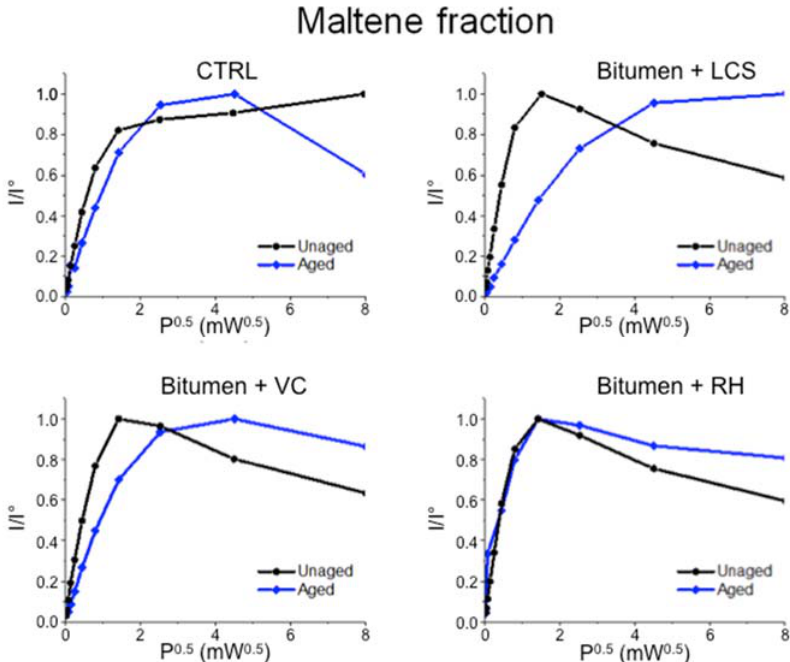
Figure 8. Power saturation profiles for maltene samples mixed with 2% w/w of antioxidants, as determined from the X-band EPR spectra registered at room temperature. CTRL indicates the control sample with no antioxidant added. Black lines, full circles: unaged samples; blue lines, full diamonds: samples artificially aged through the RTFOT method.